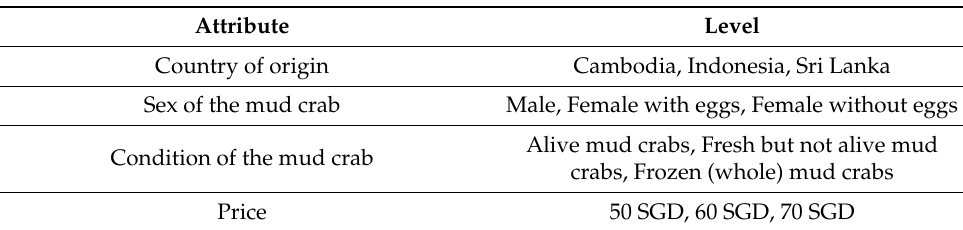
Table 1. Attributes and levels in the DCE.